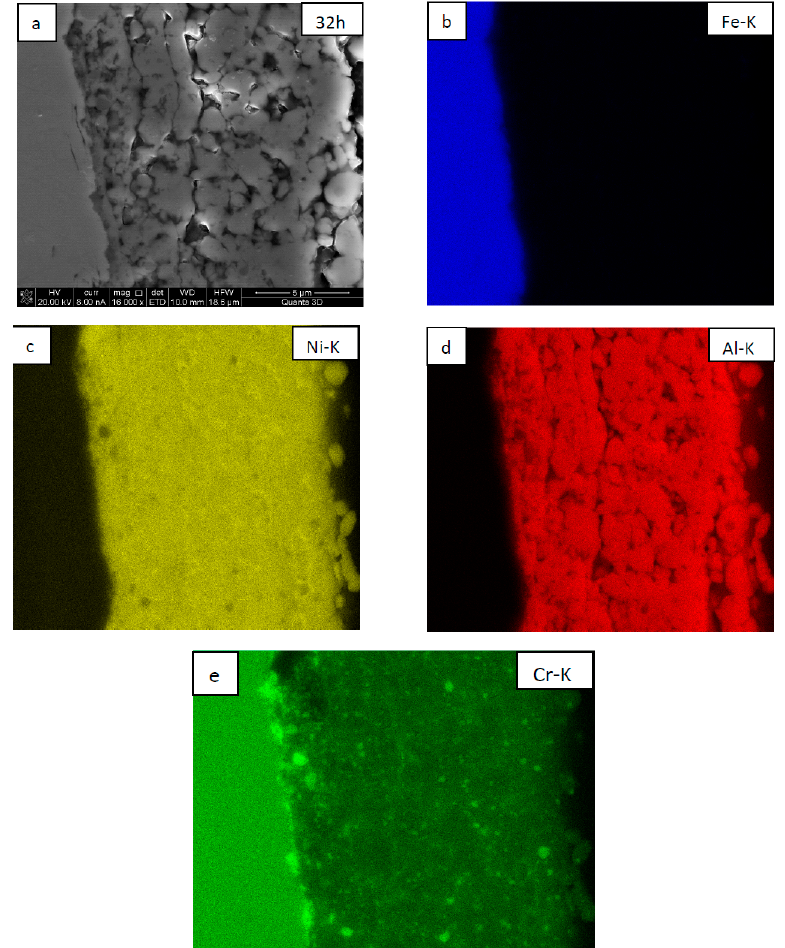
Figure 5. SEM/BSE image of NiAl + CrB 2 coatings deposited on nickel substrate after 32 h of milling ( a ) and maps presenting the distribution of nickel ( b ), aluminum ( c ), and chromium ( d ).